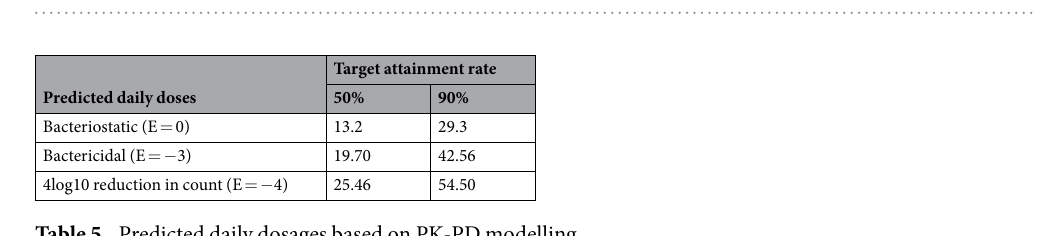
Table 5. Predicted daily dosages based on PK-PD